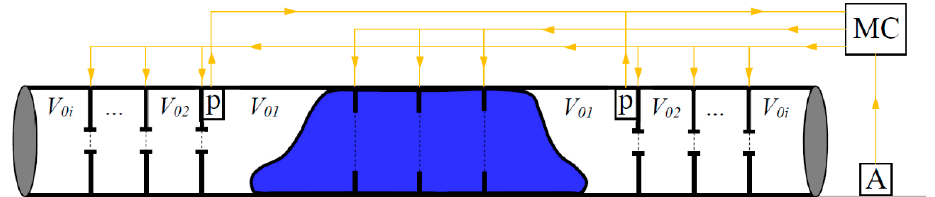
Figure 1. Novel single tube semi-active Tuned Liquid Gas Damper (SA-TLGD).